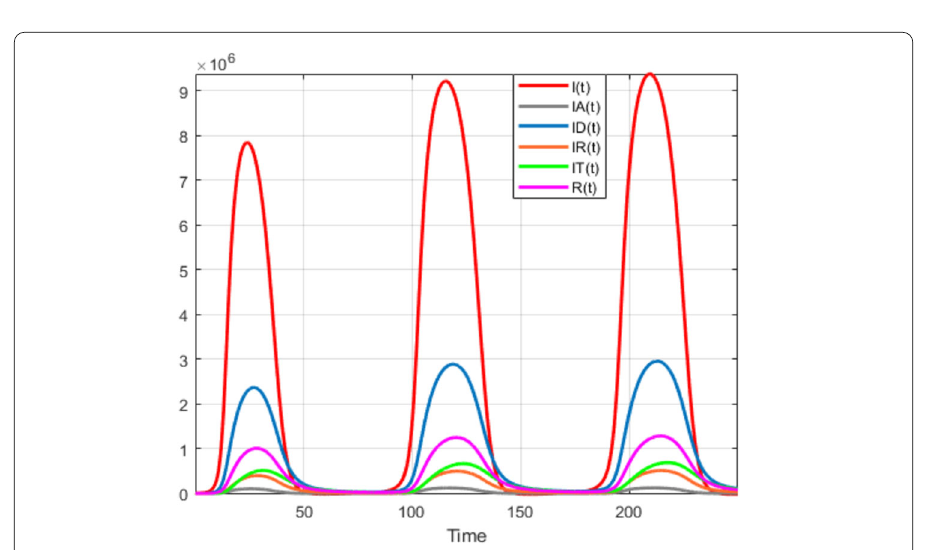
Figure 32 Numerical visualization of COVID-19 model for α =